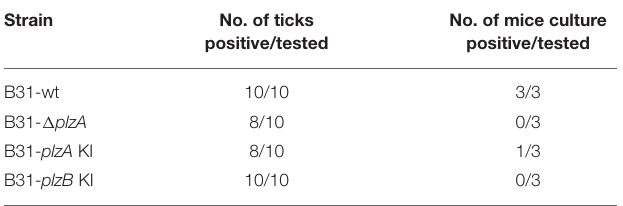
TABLE 4 | Tick to mouse transmission analysis. Strain